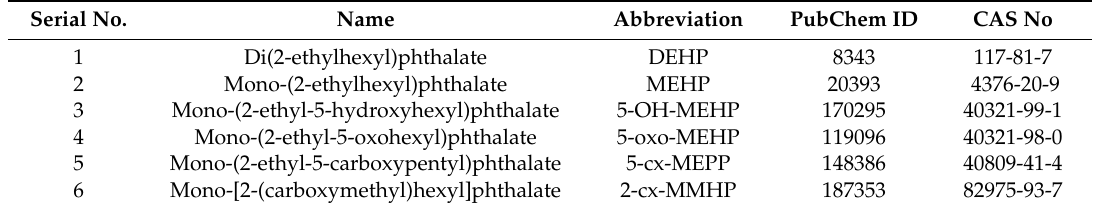
Table1. Ligandname, commonabbreviations, PubChemIDsandChemicalAbstractServiceRegistration Number (CAS No.) of di(2-ethylhexyl) phthalate and its five major endogenous metabolites. Serial